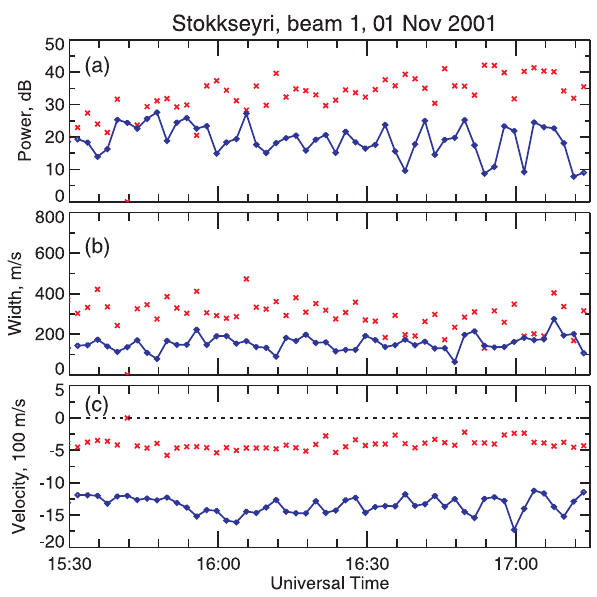
Fig. 5. Temporal variations of (a) the echo power, (b) spectral width and (c) velocity for the E-region and F-region echoes (inferred from short- and far-range data, as discussed in the text). Red crosses represent the E-region parameters while blue diamonds connected by the blue lines represent F-region